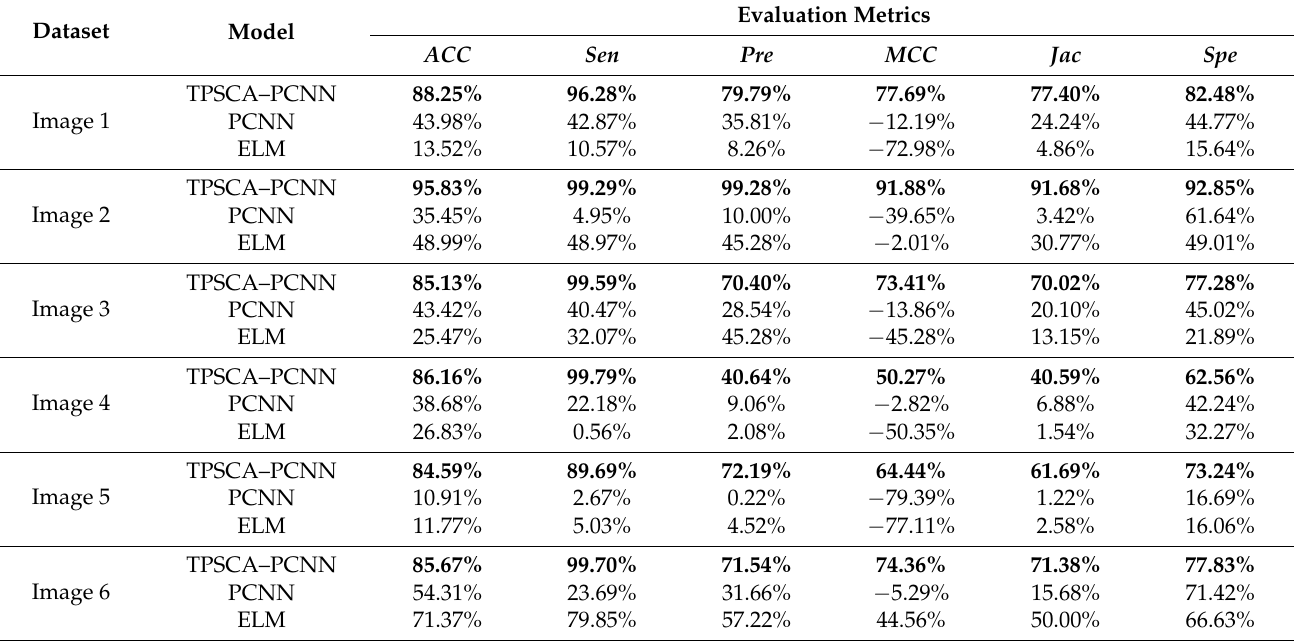
Table 10. The experimental results of image segmentation using TPSCA–PCNN, PCNN, and ELM.